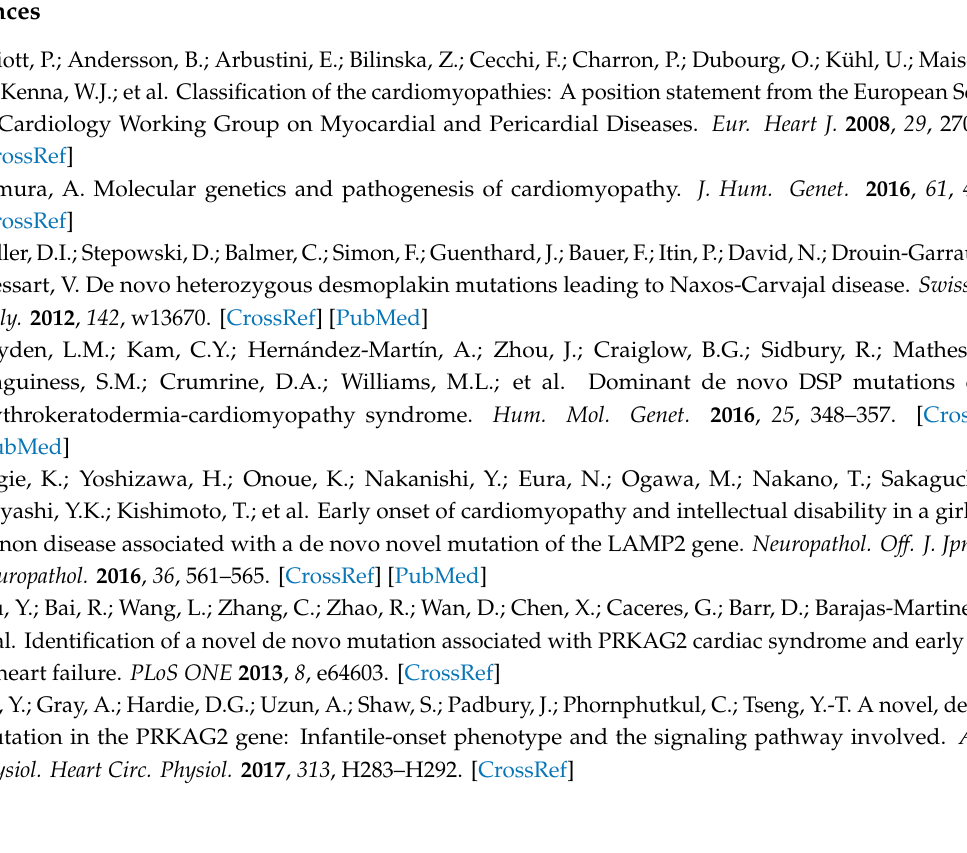
Figure S1: The pedigrees of families with de novo variants in known cardiomyopathy genes and corresponding Sanger chromatograms, Table S1: Technical parameters of WES in trios, Table S2: Detailed clinical characteristics of probands, Table S3: Other rare ( < 0.00001 in gnomAD) variants identified in probands as inherited from a parent, Table S4: The ages of parents of probands’ with de novo